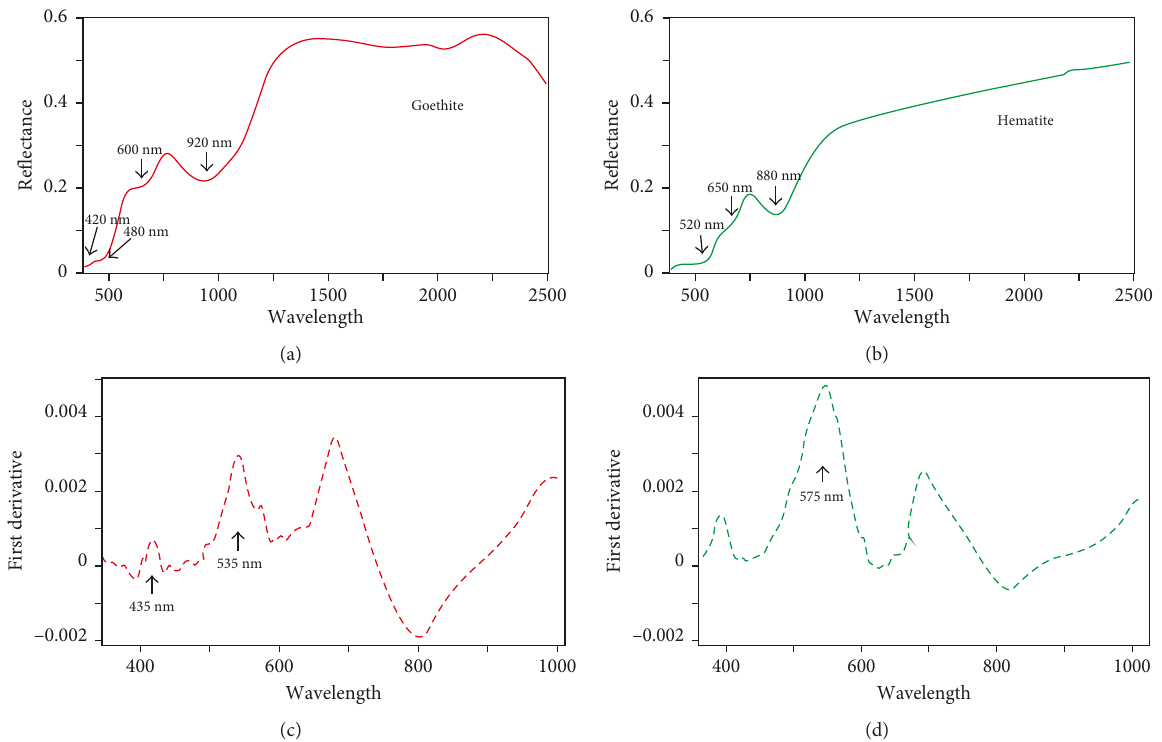
Figure 3: Raw spectra for goethite (a) and hematite (b) and the first-derivative spectra of goethite (c) and hematite (d) (modified from Zheng et al. [39]).